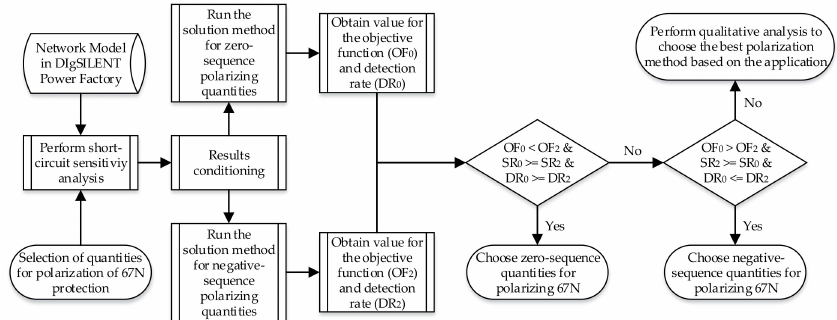
Figure 7. Flowchart for choosing the polarizing quantities for the directional ground overcurrent protection element (ANSI